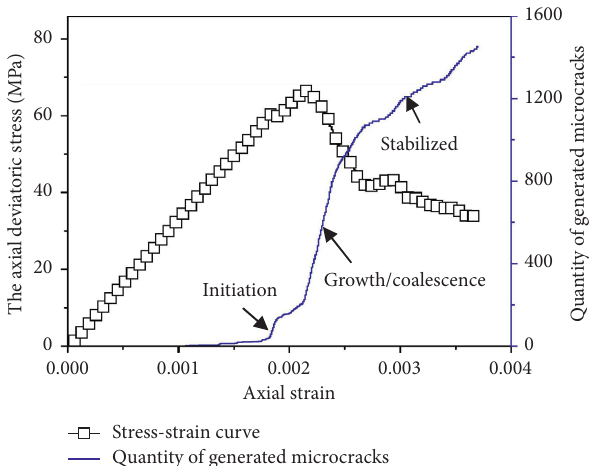
Figure 8: Relationship between the quantity of microcracks and axial stress-strain curve.